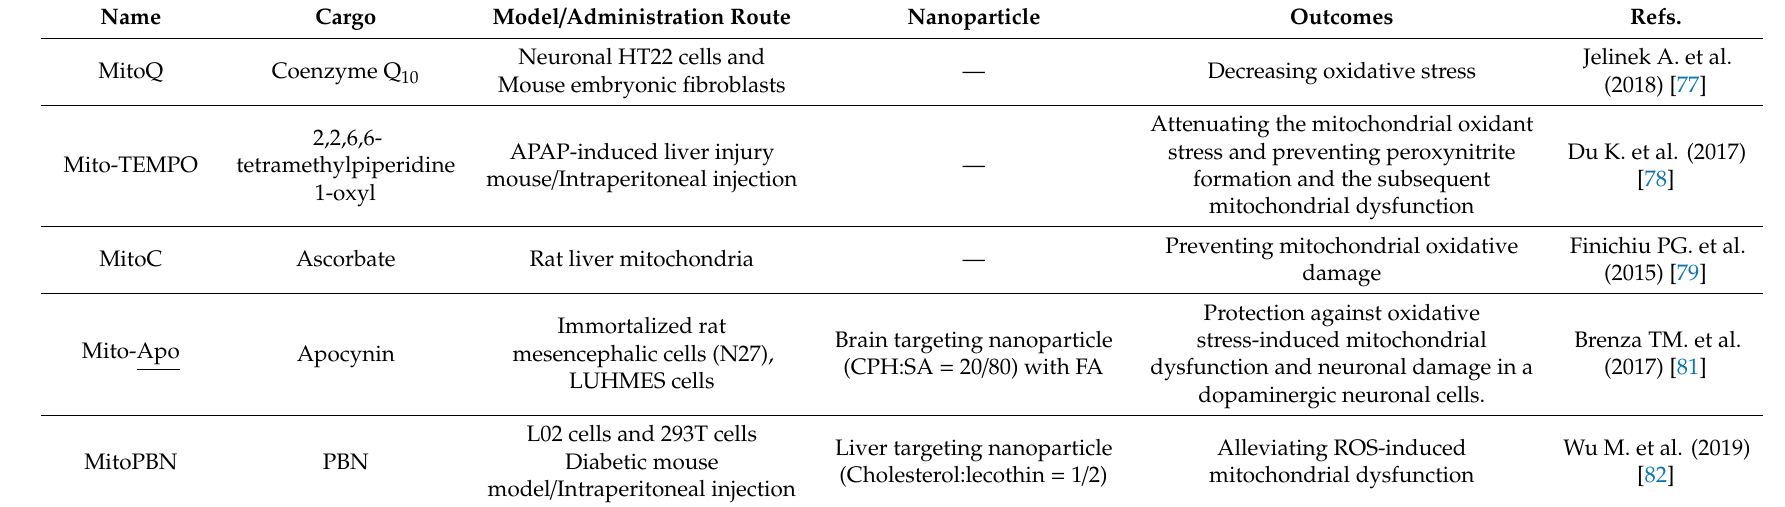
Table 2. Summary of mitochondrial antioxidants delivery using TPP